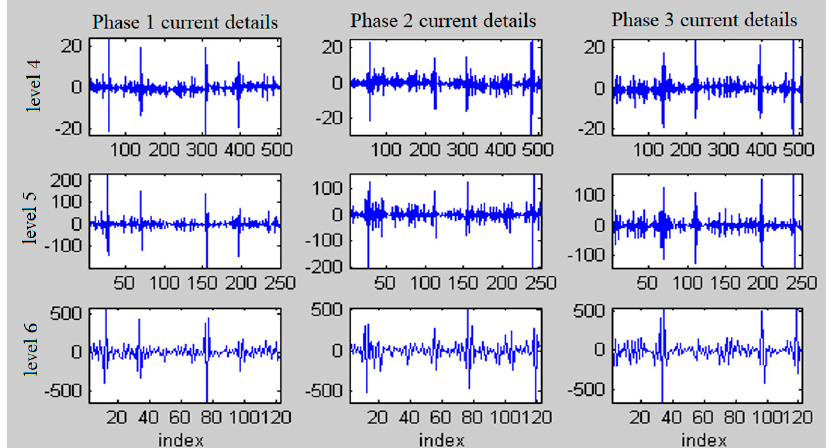
Figure 16. Vectors of details for currents, levels 4–6, first case study.